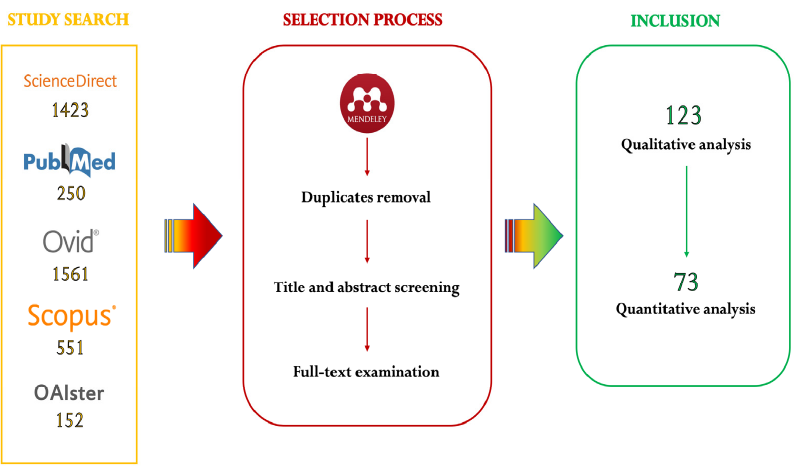
Figure 1. Papers included in our analyses according to our original search.